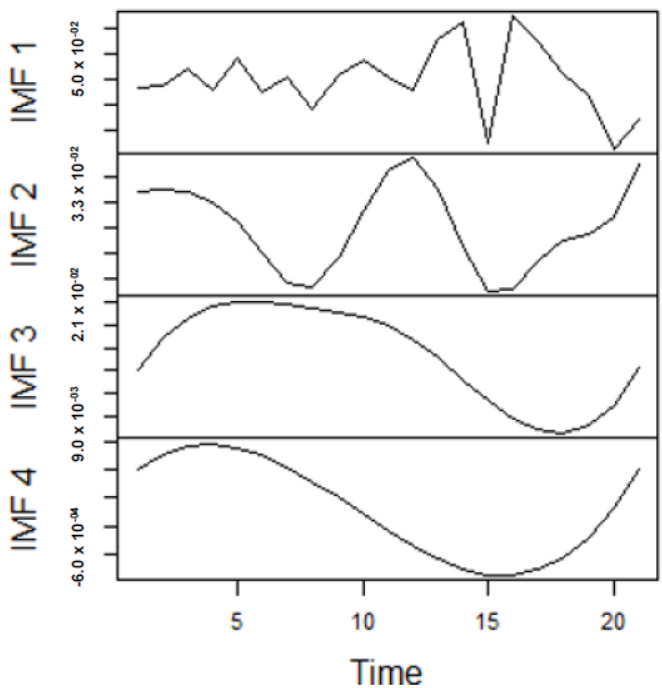
Figure 11. Panel A: Part of the IMFs for Japan gas prices in stressful